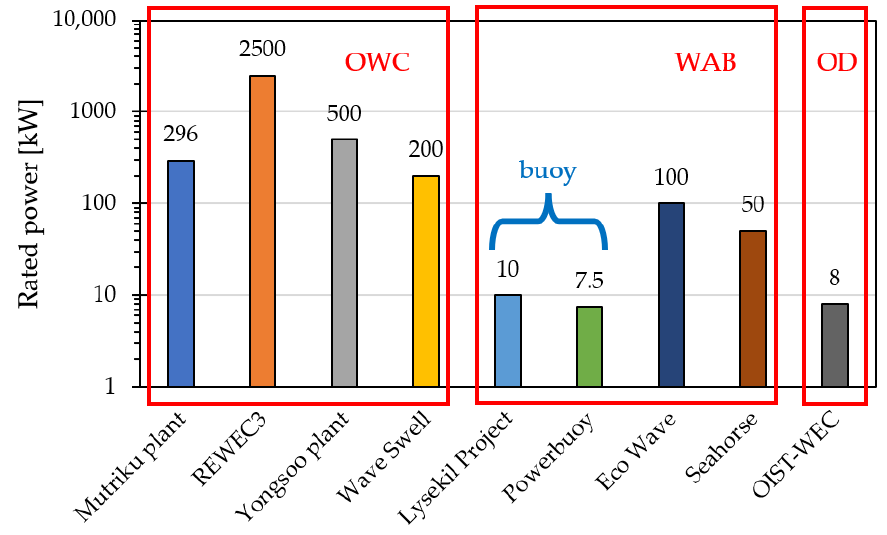
Figure 33. Rated power of the operating wave-energy